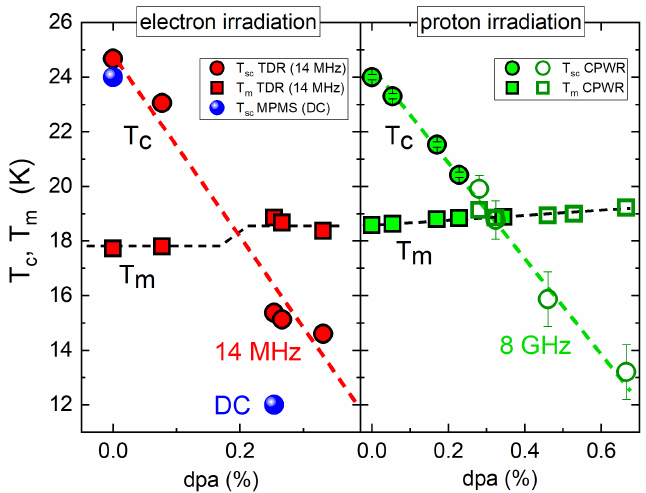
Figure 8. Transition temperatures vs. the estimated atomic concentration of defects in EuFe 2 ( As 1 − x P x ) 2 single crystals obtained by different techniques and different doses of irradiation. (Left panel) electron irradiation in x = 0.23 crystal, measurements using (red) tunnel-diode resonator (TDR) and (blue) DC magnetometry; (Right panel) proton irradiation in x = 0.23 (hollow symbols) and x = 0.20 (full symbols) crystals, measurements using coplanar waveguide resoantor (CPWR). The way the effective disorder has been estimated in this case was discussed in